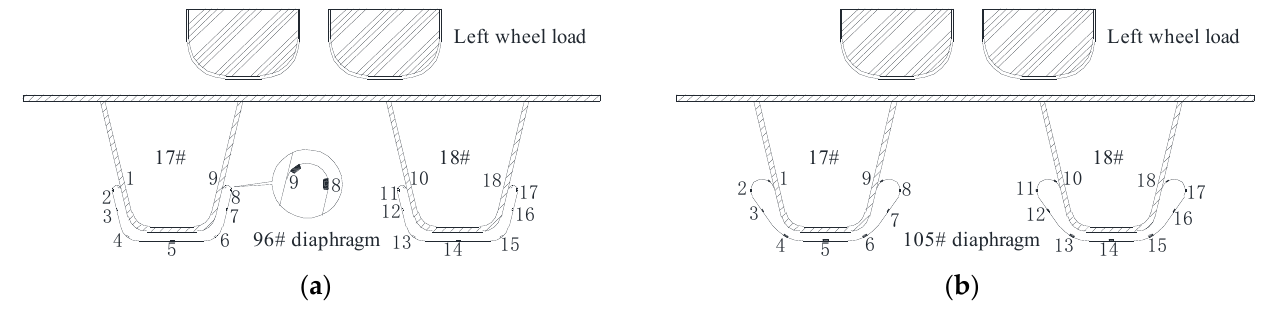
Figure 10. Schematic diagram of the layout of the strain measuring points of the arc-shaped cut section before and after reinforcement: ( a ) Before reinforcement, ( b ) after reinforcement.